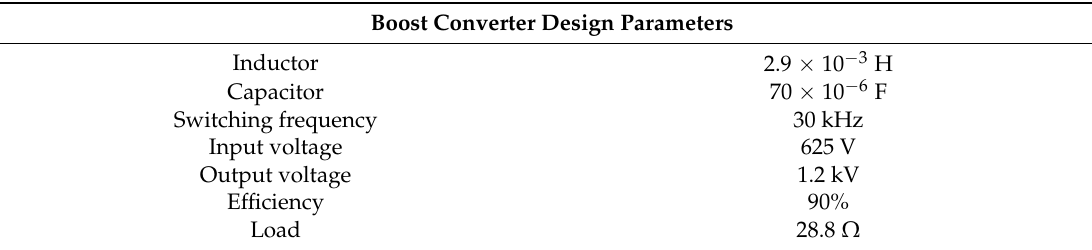
Table 2. Converter